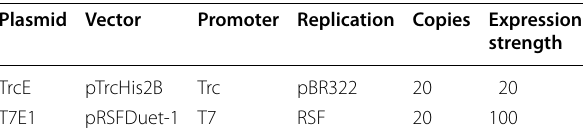
Table 1 Comparison of the expression strength of the MVA pathway Plasmid Vector Promoter Replication Copies Expression